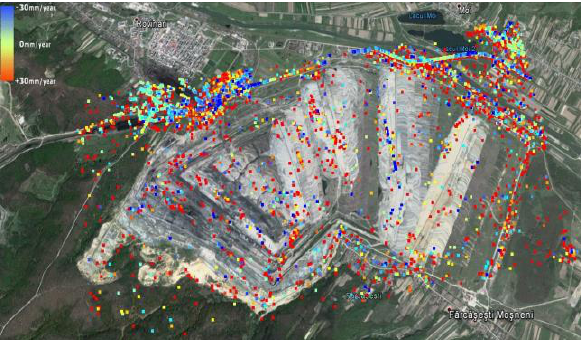
Figure 4. Spatial distribution of the PS points: Red points indicate uplift (excavated) areas and blue point shown downlift (in the main pit) or subsidence (tailings